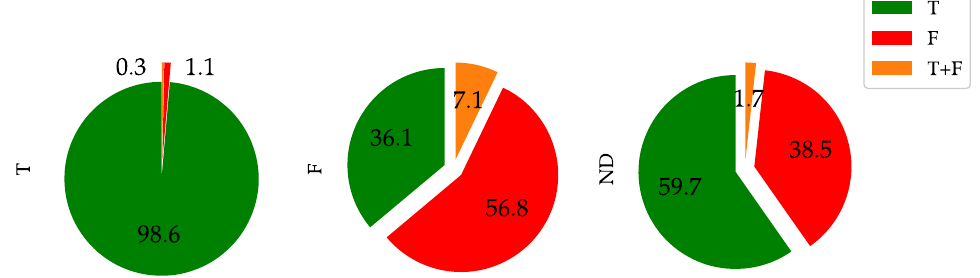
Figure 12. Validity assessment comparison: 2nd Harmonic labels with respect to DELFI outcomes for the Overall Set.